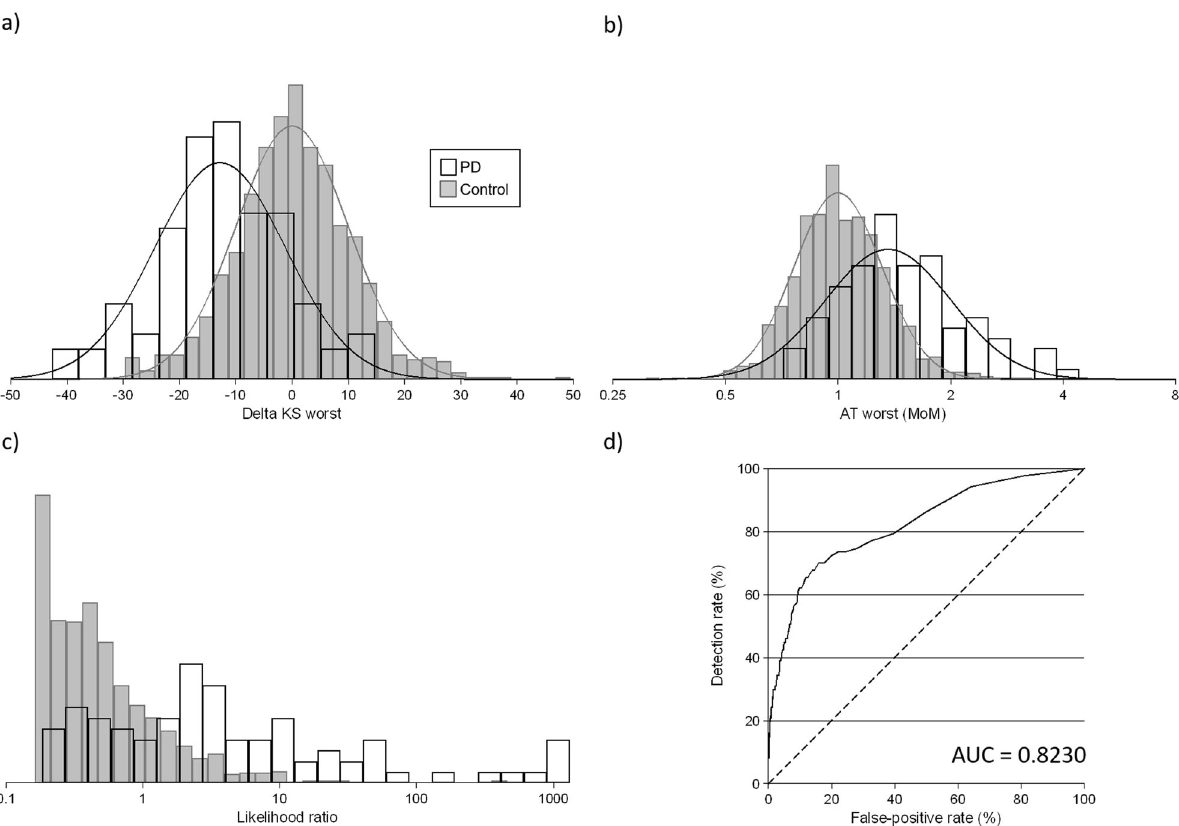
Fig. 4 Classi fi cation of Parkinson ’ s Disease (PD) based on the Bradykinesia Akinesia Incoordination (BRAIN) test. a Distributions of kinesia score (difference from the median [delta] KS) in PD cases and controls. b Distributions of akinesia time (multiple of the median [MoM] AT) in PD cases and controls. c Distributions of likelihood ratios based on the multivariate Gaussian distributions of KS and AT. d The observed detection rate according to false-positive rate (receiver operating characteristic curve) based on the multivariate Gaussian distributions of KS and AT. AUC, area under the receiver operating characteristic